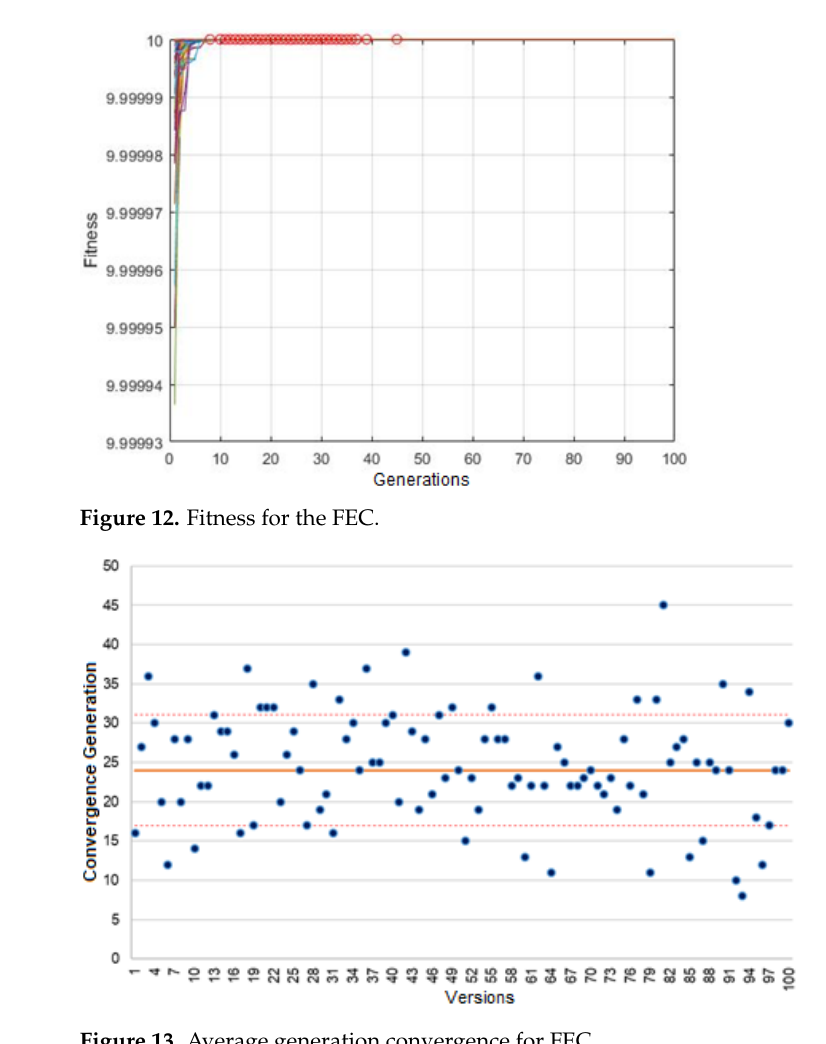
15 of 21 Figure 9. Estimated DEC values per generation. Figure 10. Estimated final DEC values. Figure 11. Relative absolute error DEC.